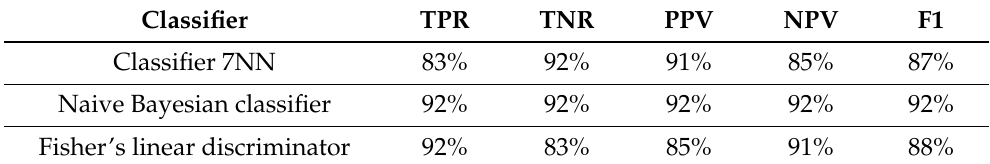
Table 5. Classic metrics for binary classification.